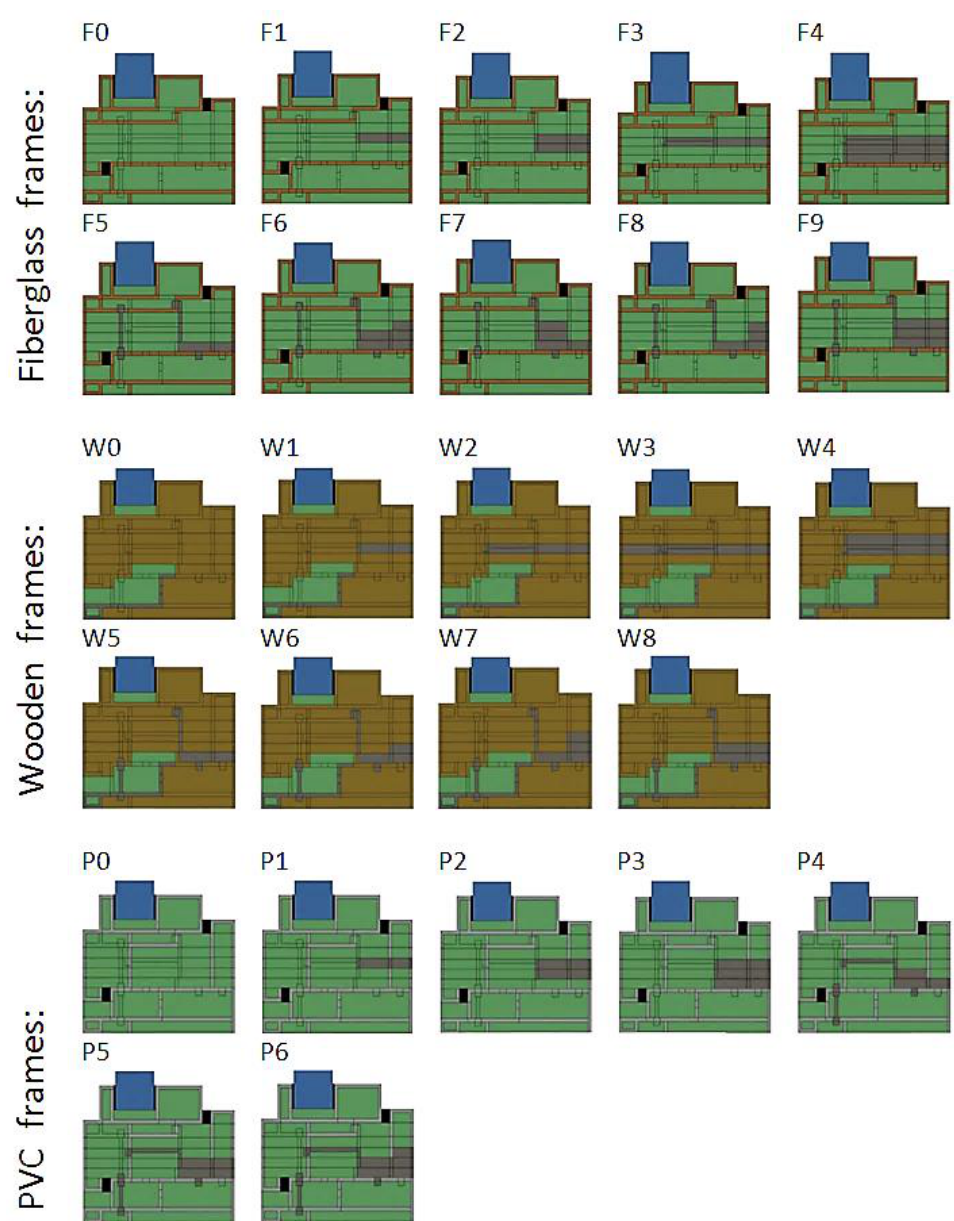
Figure 4. Base frame cross-sections and associated hardware configurations investigated in the study. Dark grey indicates operating hardware, blue is glazing panel, and green is air cavities. All other colors present materials typical for the frame type, dark brown is fiberglass, light brown is wood, and light grey is PVC (refer to the electronic version for colors).